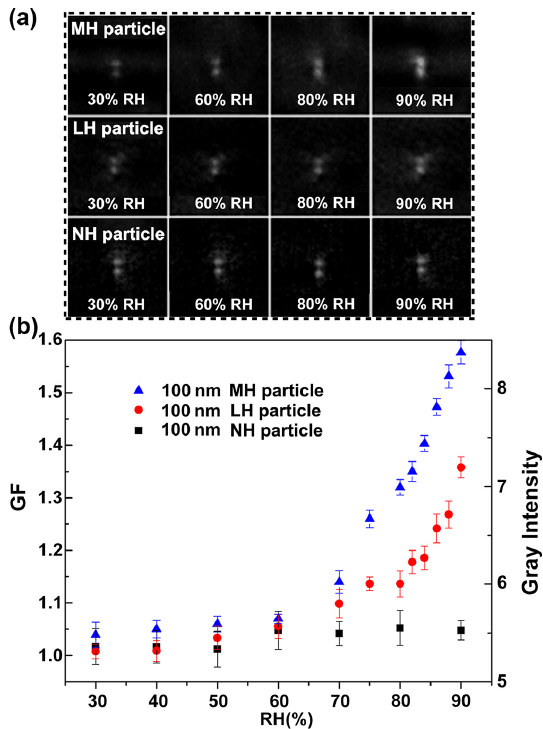
Figure 2. (a) SPRM-ARI images and (b) hygroscopic growth fac- tors of 100nm atmospheric particles on 28 September